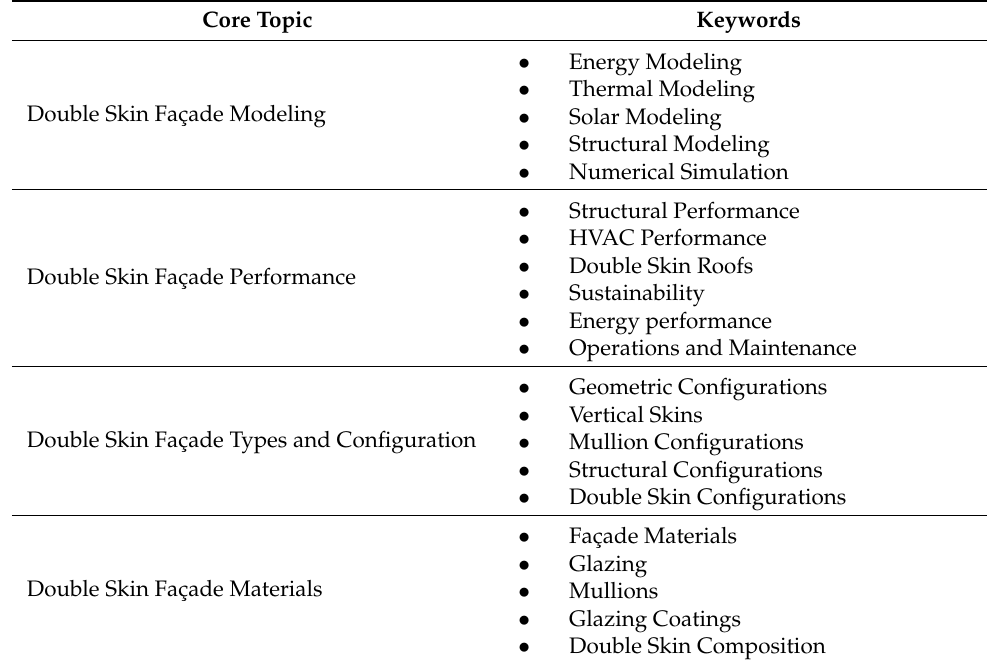
Table 1. Paper Selection Criteria for Identification of